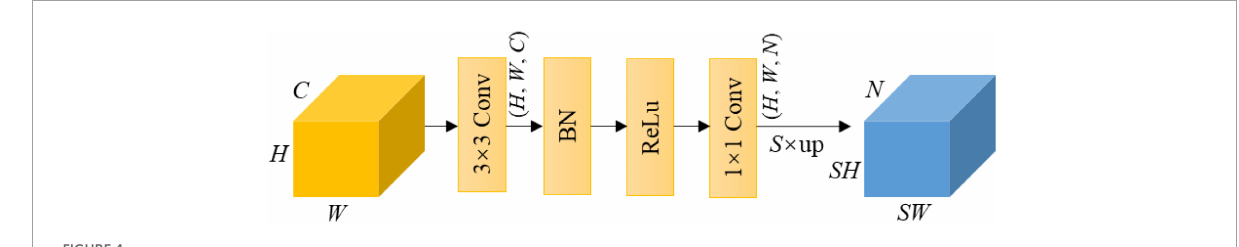
FIGURE4 Illustration of the segmentation head. Note that S is the scale ratio of up-sampling, and N is the number of